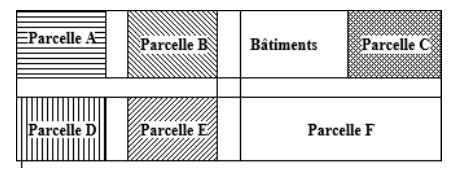
Figure 2. Configuration de l’espace d’une exploitation agricole fa-